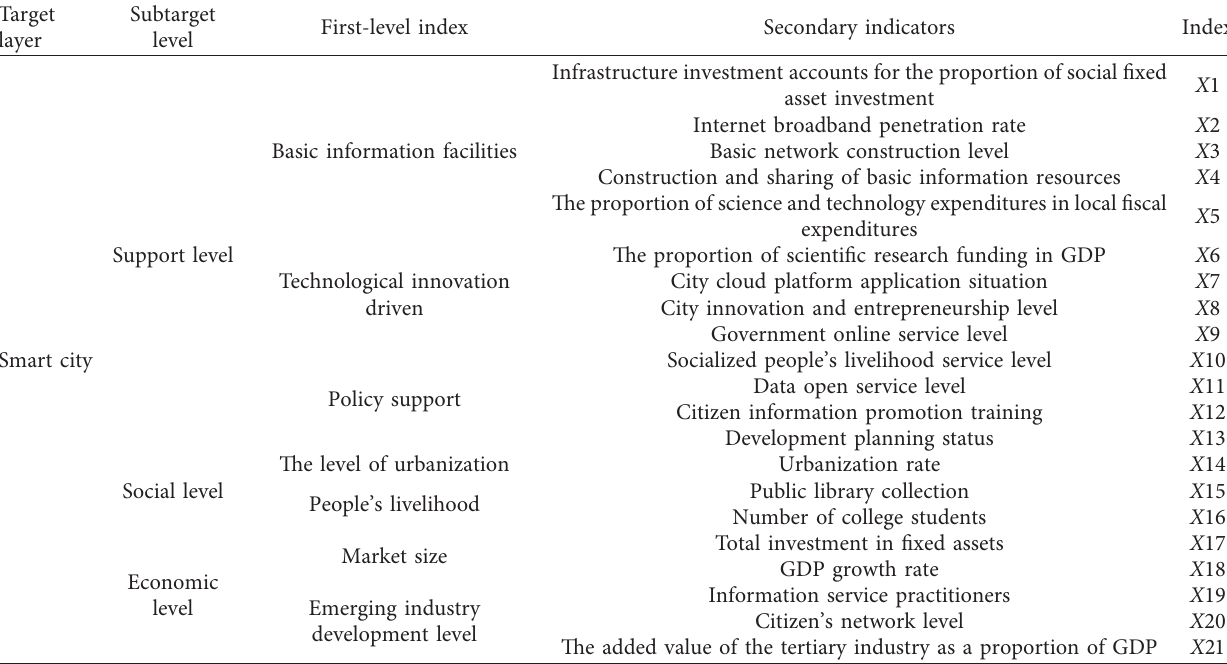
Table 4: Evaluation index system of sustainable development level of smart